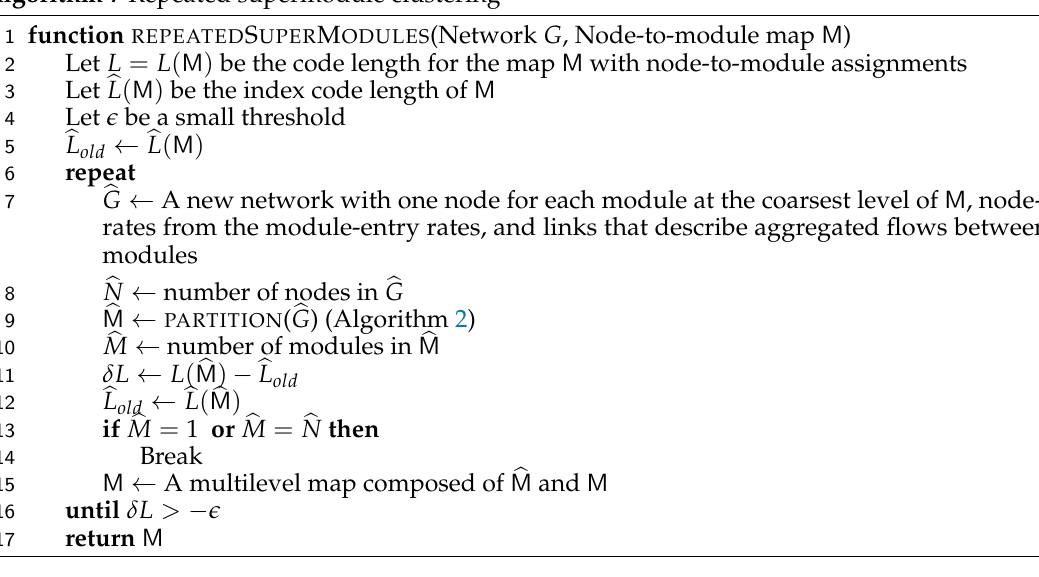
Algorithm 7 Repeated supermodule clustering